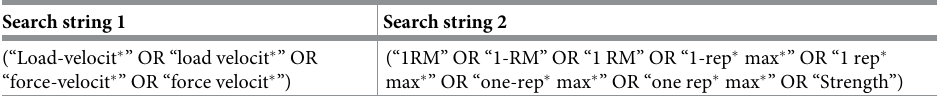
Table 1. Search terms used for literature